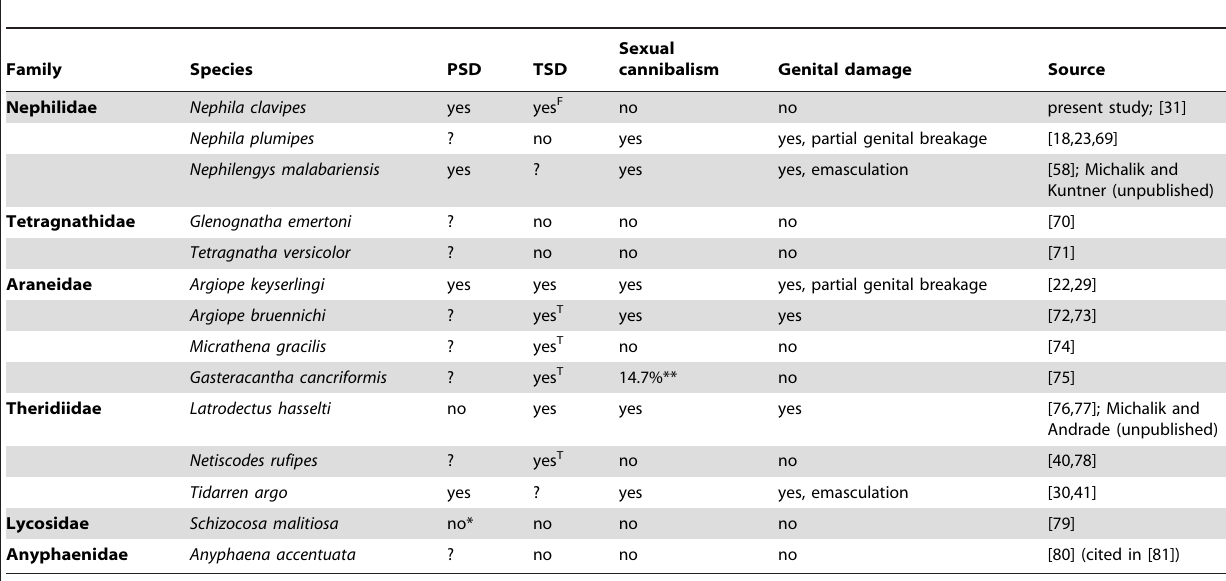
Table 1. Overview of sperm depletion in spiders as it relates to sexual cannibalism and genital damage during copulation.